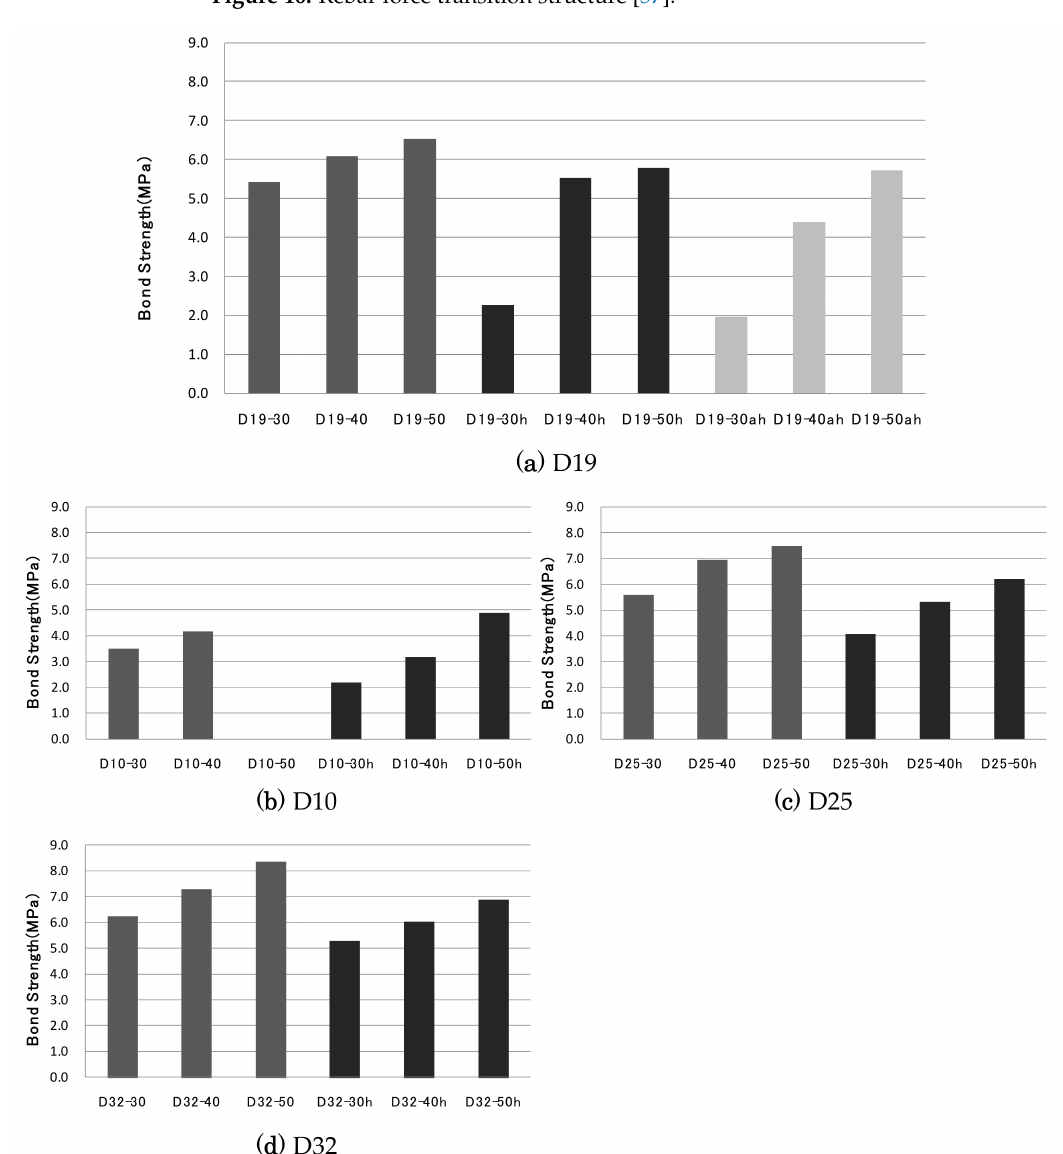
Figure 17. Reinforced concrete extraction experiment results (D00-000: D reinforcement type-distance mm-heating-all